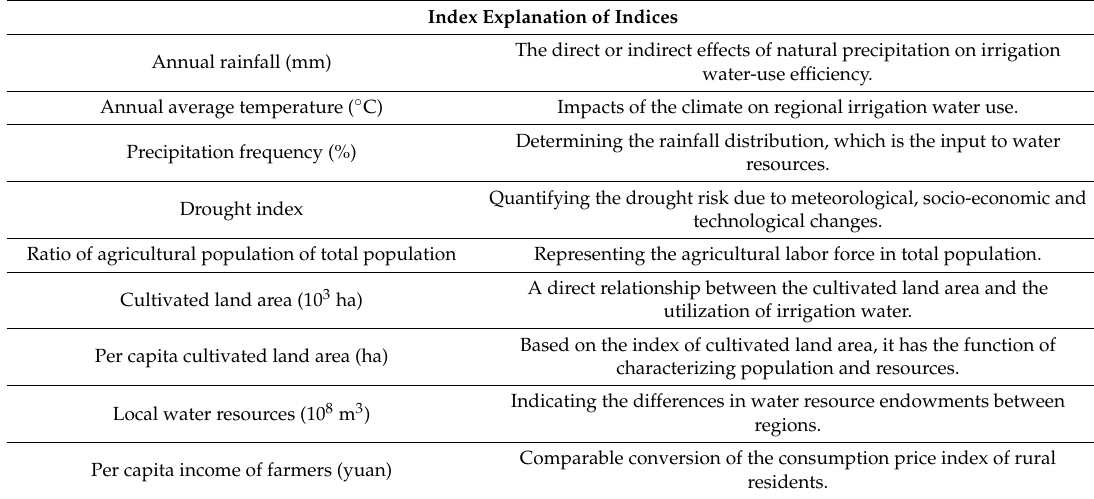
Table 1. Explanation of irrigation water-use efficiency change driving